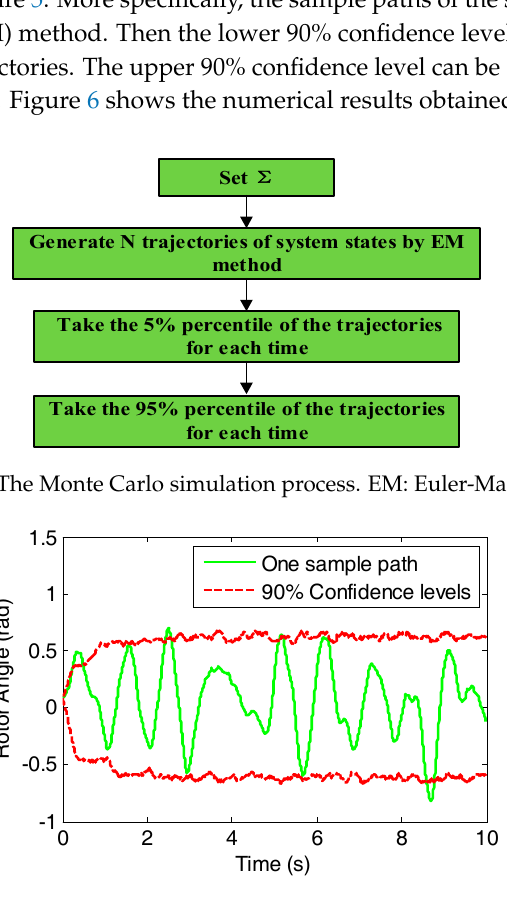
Figure 6. The rotor angle response of the sSMIB.